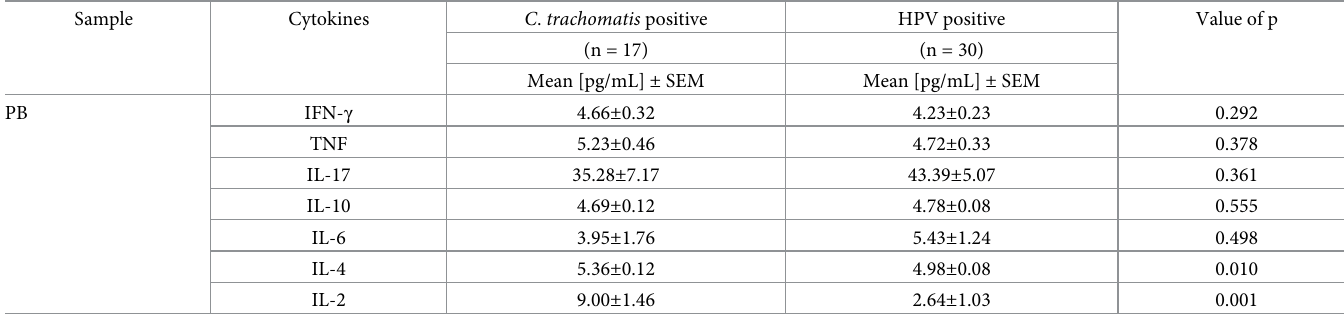
Table 3. Cytokine levels in the peripheral blood (PB) samples of patients with Chlamydia trachomatis infections and HPV infection.